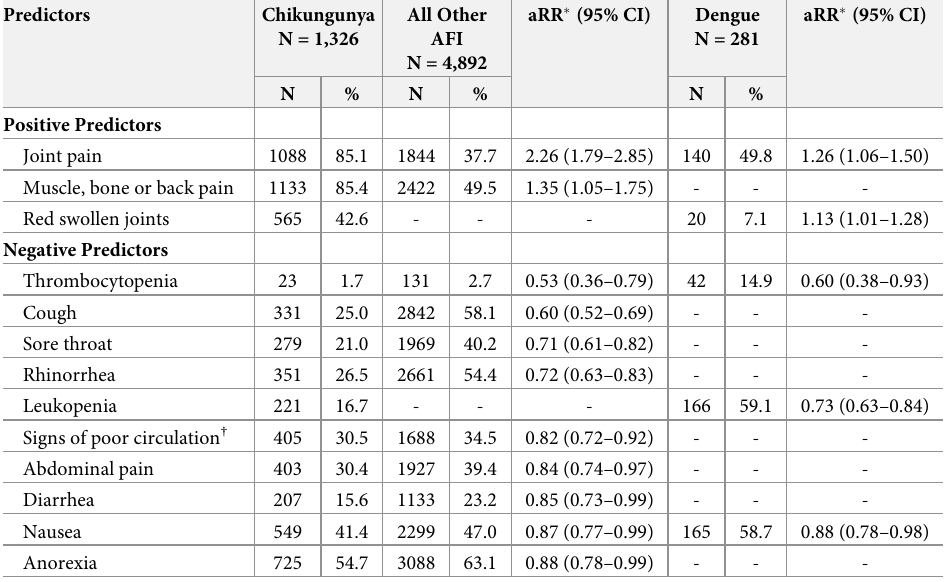
Table 4. Early predictors of laboratory-confirmed chikungunya versus all other acute febrile illnesses or labora- tory-confirmed dengue for participants of all ages, Acute Febrile Illness Study, May 7, 2012–May 6, 2015, Puerto Rico.